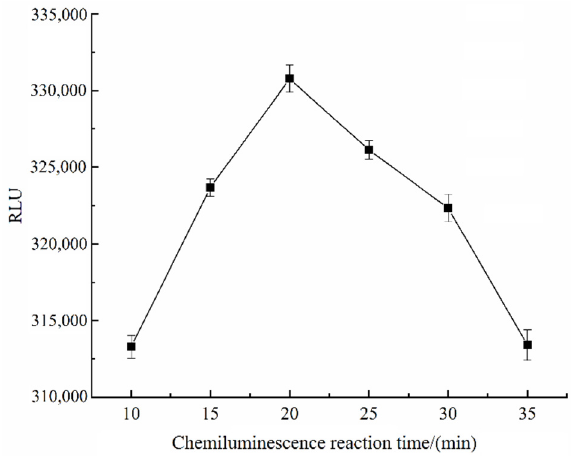
Figure 5. RLU values at different chemiluminescence reaction time.